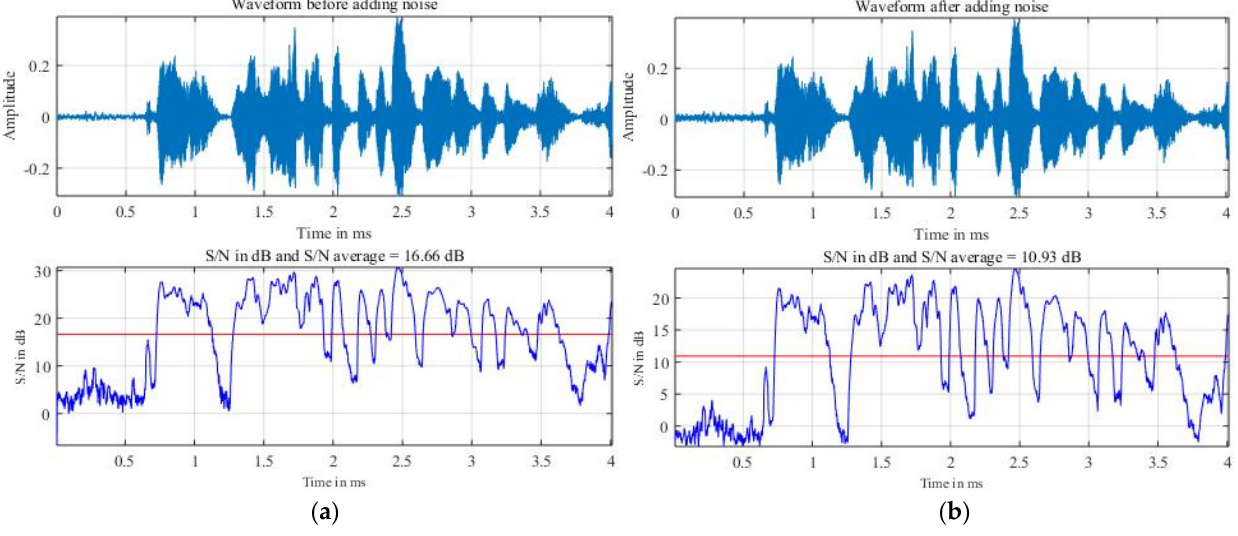
Figure 4. Illustration of waveform and average signal/noise ratio before and after white noise addition. ( a ) Before adding noise. ( b ) After adding noise.